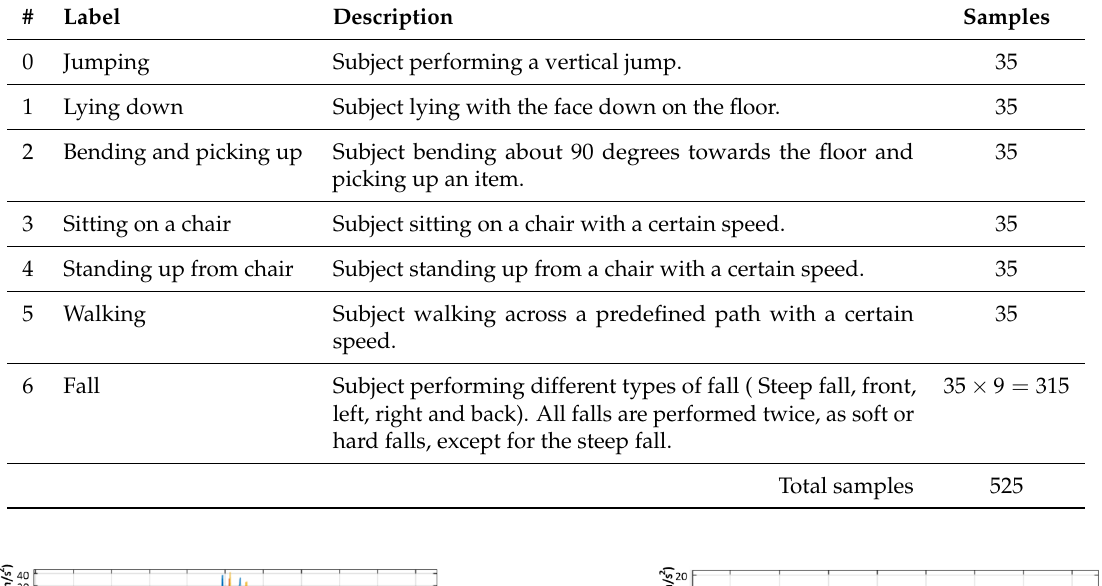
Table 1. Activities performed by the participants of this study.